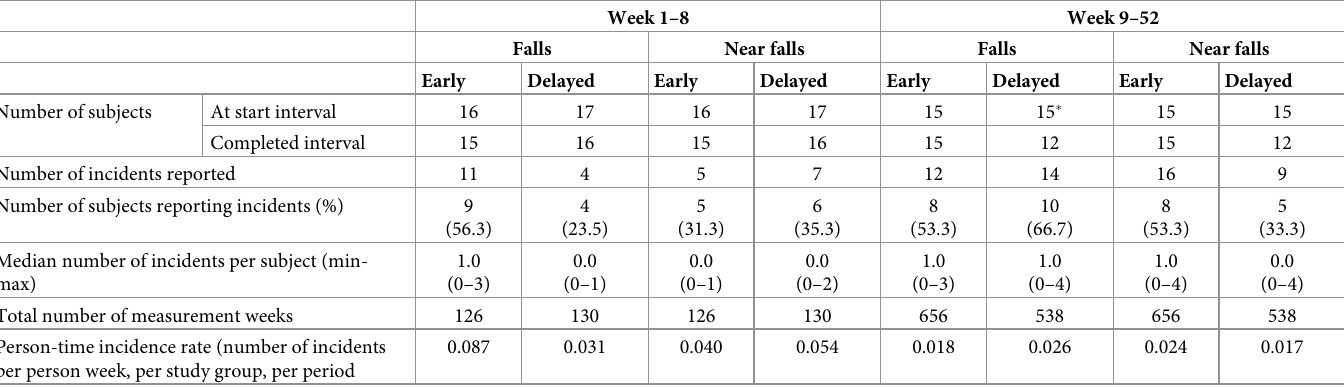
Table 3. Total number of falls and near falls in week 1–8 and